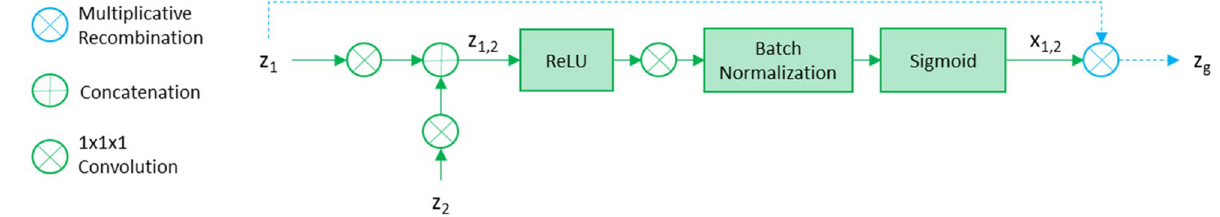
Figure 1. The attention gating mechanism is shown for the propagation signal z 1 , gating signal z 2 , and final gated output signal z g for the discriminator and generator